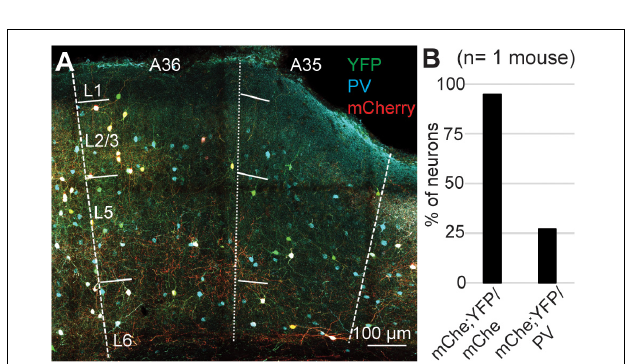
FIGURE 6 | (A) Representative confocal stack showing the overlap of PV (turquoise), YFP (green) and mCherry (red) in PER. (B) Bar plot showing the percent of mCherry-expressing neurons that also expressed YFP, and the percent of PV-expressing neurons labeled by mCherry and YFP.